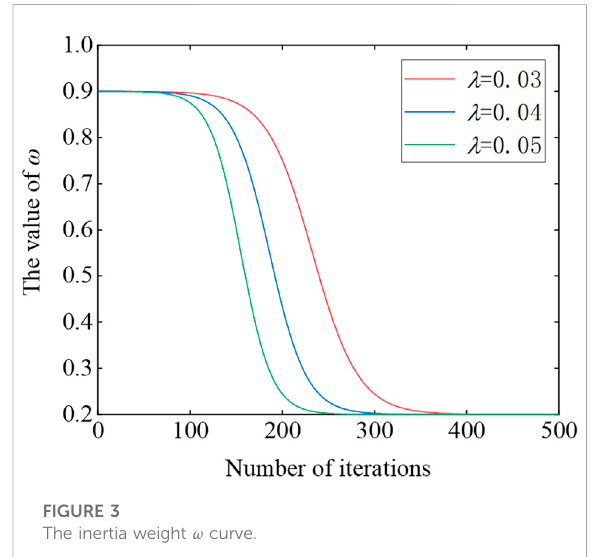
FIGURE 3 The inertia weight ω